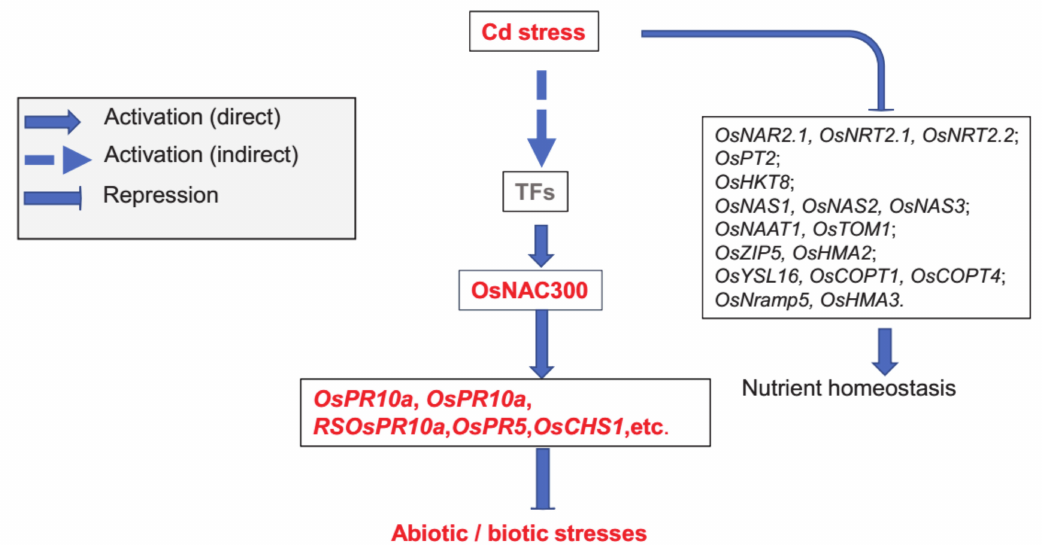
Figure 8. The OsNAC300-dependent Cd stress response regulatory pathway in rice roots. In rice, the Cd stress signal activates downstream gene expression through OsNAC300-dependent and OsNAC300-independent regulatory pathways. In the OsNAC300-dependent regulatory pathway, OsNAC300 directly binds to promoter regions containing CATGT of Cd stress response genes, including OsPR10a , OsPR10b , and OsCHS1 , which respond to abiotic and biotic stress. On the other hand, the Cd stress signal also regulates other nutrient homeostasis (e.g., OsNAR2.1, OsNRT2.1 and OsNRT2.2 ) that are not dependent on